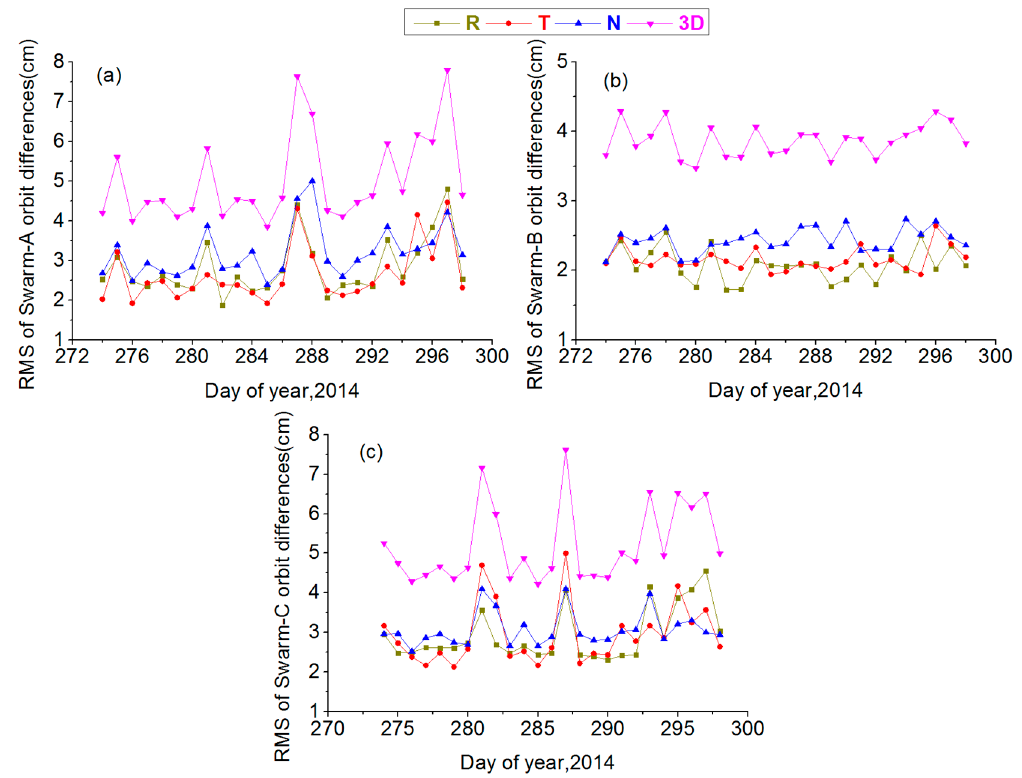
Figure 8. RMS values of orbit differences for Swarm-A, Swarm-B and Swarm-C in the radial (R), along-track (T) and cross-track (N) directions during DOY 274–298, 2014: ( a ) RMS values of Swarm-A orbit differences; ( b ) RMS values of Swarm-B orbit differences; ( c ) RMS values of Swarm-C orbit differences. Table 3. Mean RMS values of orbit differences for Swarm-A, Swarm-B and Swarm-C during DOY 274–298, 2014.